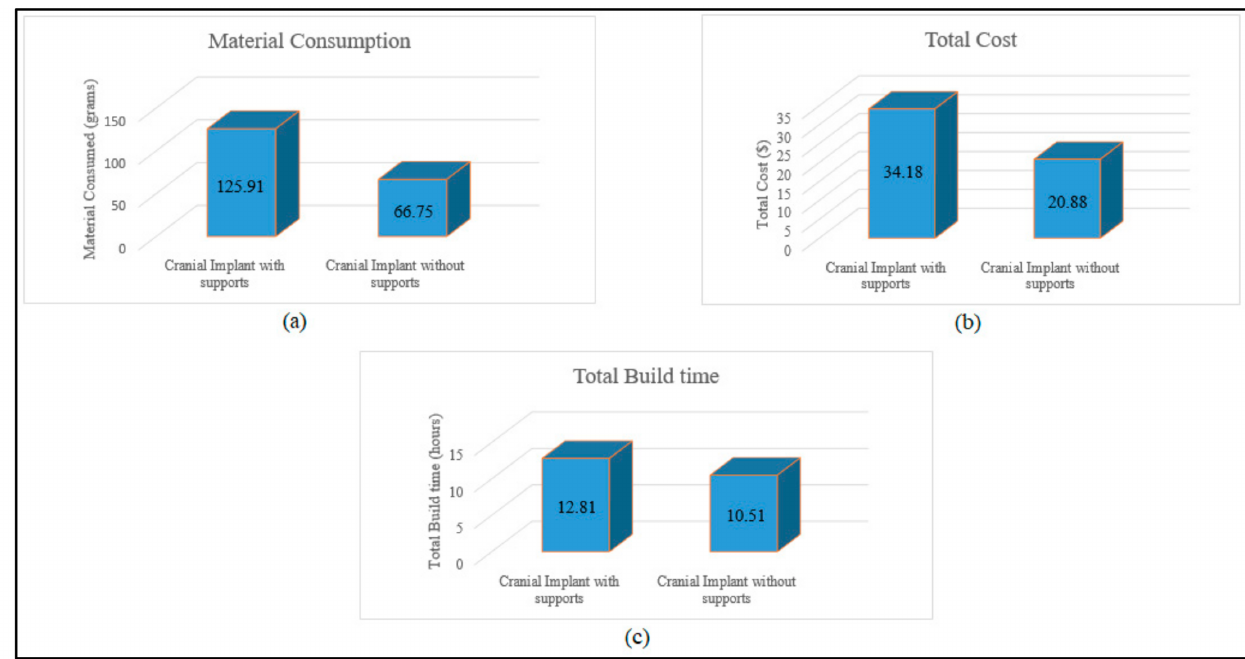
Figure 14. Comparative analysis of cranial implants with and without supports ( a ) material consumption; ( b ) total cost; and ( c ) total build time.